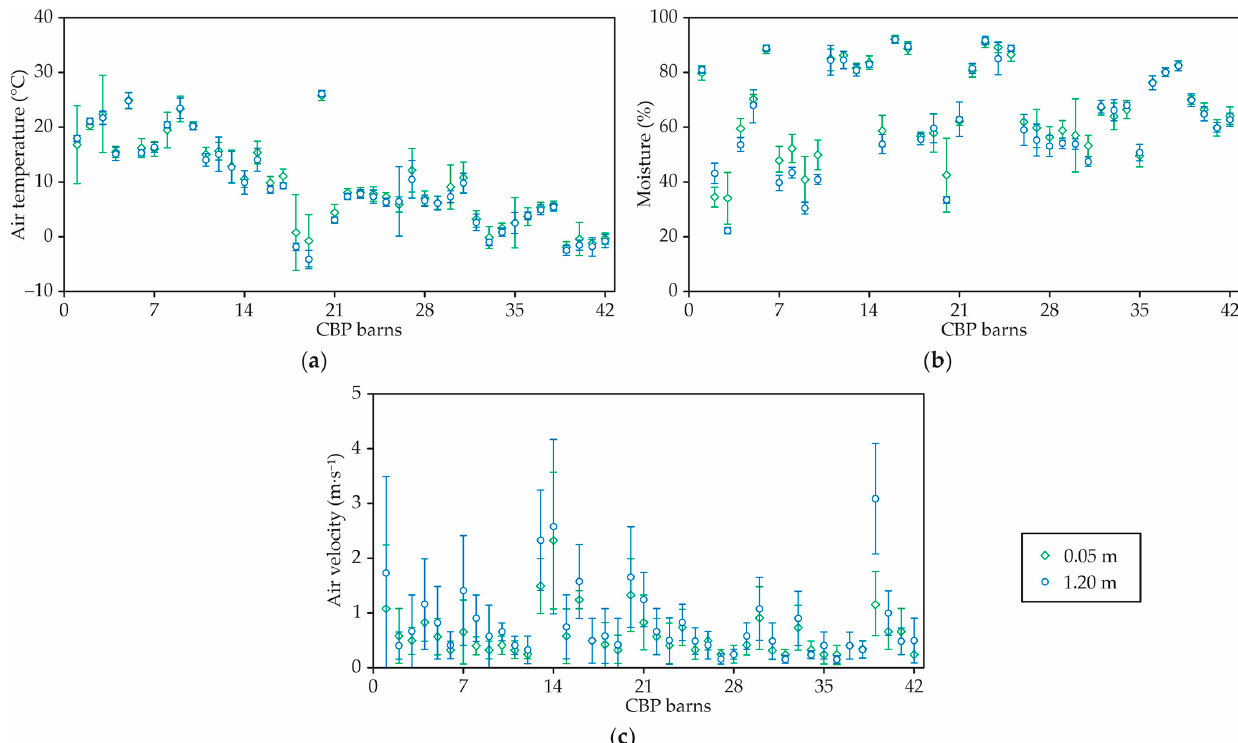
Figure 6. Average of ( a ) air temperatures, ( b ) relative humidity, and ( c ) air velocity measured at two heights (0.05 and 1.20 m) inside 42 CBP barns in Kentucky.